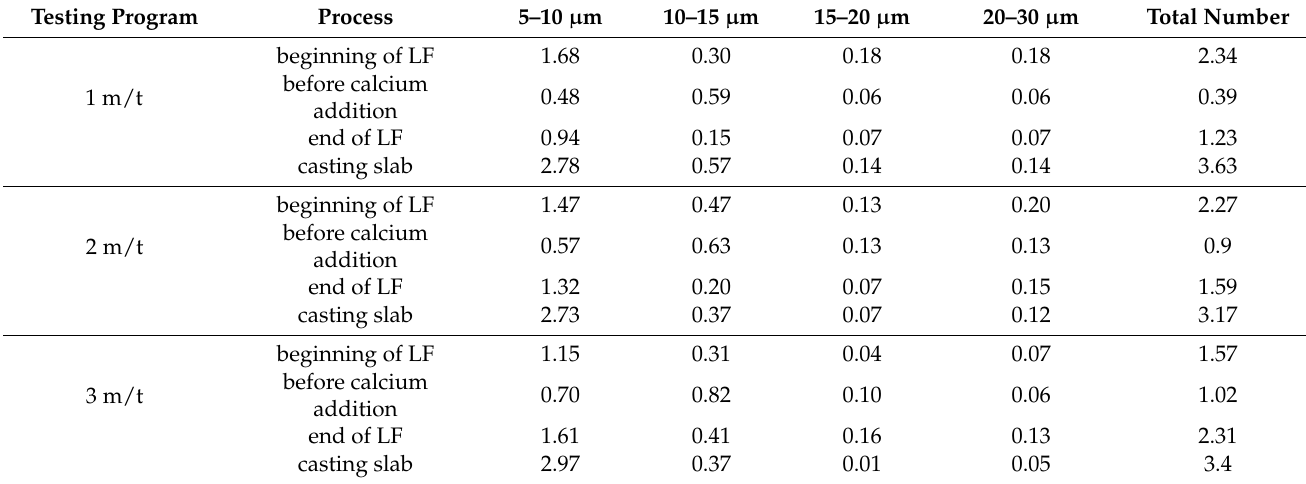
Table 8. Number and size distribution of inclusions in each process (#/mm 2 ).